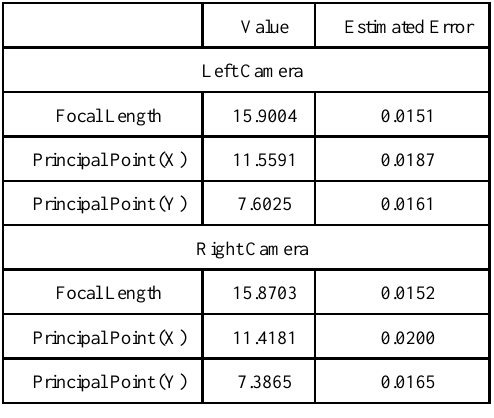
Table 2. Exterior Orientation Parameters